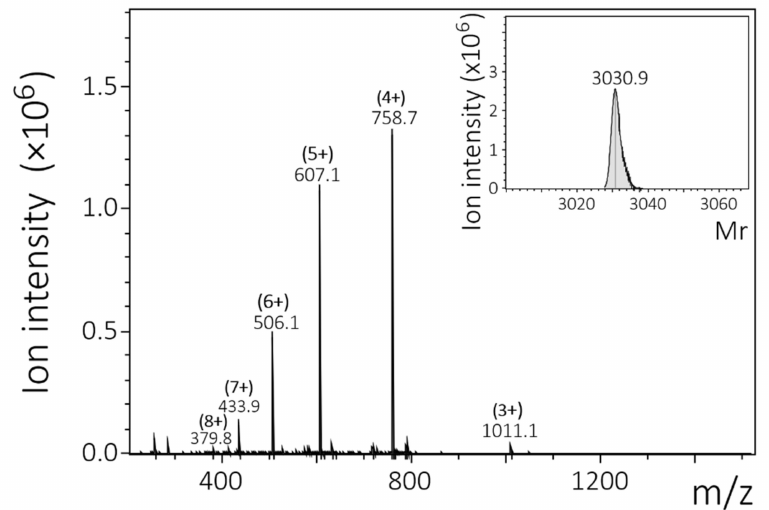
Figure 1. Identification of the chemically synthesized TAMRA-KKQK-3mer. The peptide was synthesized using Fmoc chemistry. After deprotection, RP-HPLC was used to purify the peptide and detection was performed using ion trap mass spectrometry. A mass spectrum of the peptide is shown with the intensity of the detected ions on the y-axis and the mass/charge ( m / z ) ratios on the x-axis. Deconvolution software (Bruker) was used to determine the relative molecular mass (M r ) of the uncharged peptide